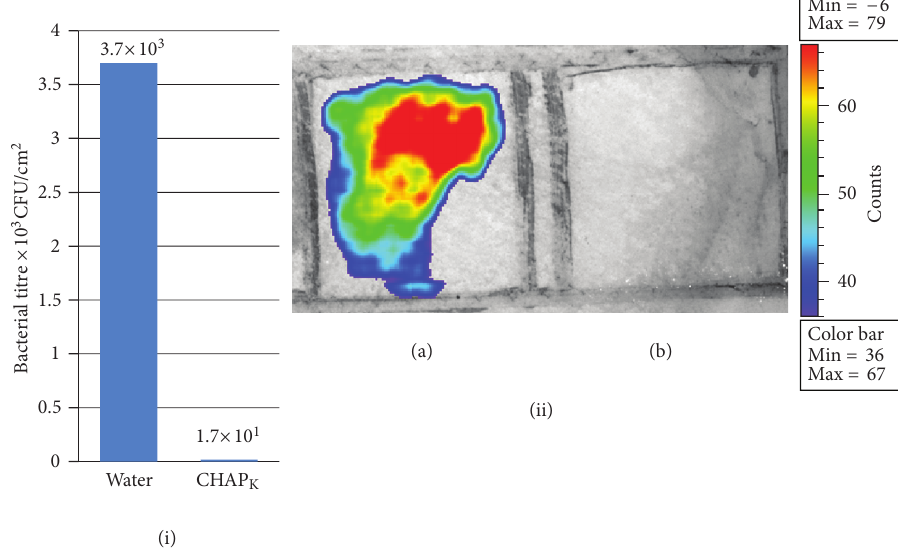
F 5: Skin decolonisation. Reduction of S. aureus on porcine skin using CHAP . (i) Two sections of porcine skin were seeded with 2.5 K CFUcm of S. aureus DPC 5246. Plate counts were performed to enumerate the S. aureus present on porcine skin 30min aer being 10 solution. (ii) Two sections of skin were seeded with 2.4 10 CFUcm of S. aureus Xen29. One sprayed with either sterile water or CHAP 5 −2 K solution (b). Skin was imaged (exposure: 15 seconds, area of skin was treated with sterile water (a) and the other area treated with CHAP × −2 K /H O using the in vivo Imaging System (IVIS) (Xenogen, Ca). binning: medium, colour-scale 36–67) 30min aer treatment with CHAP × K treatment in real time. e colour bar represents bacterial bioluminescence is system enabled direct monitoring of the effect of CHAP K 2 signal intensity, with red to blue indicating high and low bioluminescence, respectively.